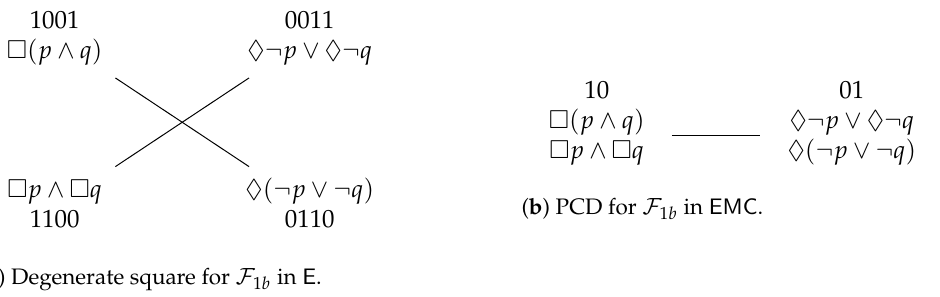
Figure 6. Aristotelian diagrams for F 1 b = { (cid:3) ( p ∧ q ) , (cid:3) p ∧ (cid:3) q , ♦ ¬ p ∨ ♦ ¬ q , ♦ ( ¬ p ∨ ¬ q ) } in two non-normal modal